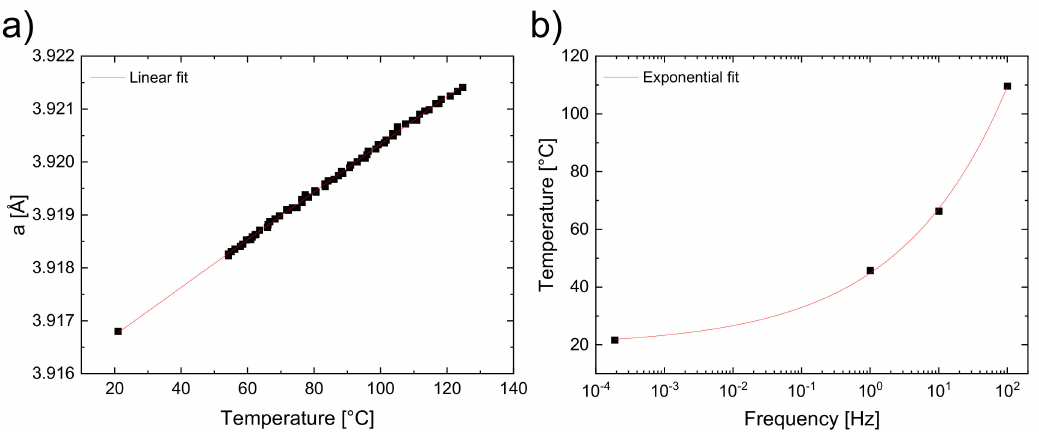
Figure 7. Temperature-dependent measurement of BNT–12BT with linear fitted unit cell parameters obtained from the Rietveld refinement ( a ). Experimental data and exponential temperature fit T = b · f c + d of di ff erent field frequencies 1.9 × 10 − 4 , 10 0 , 10 1 , and 10 2 Hz ( b